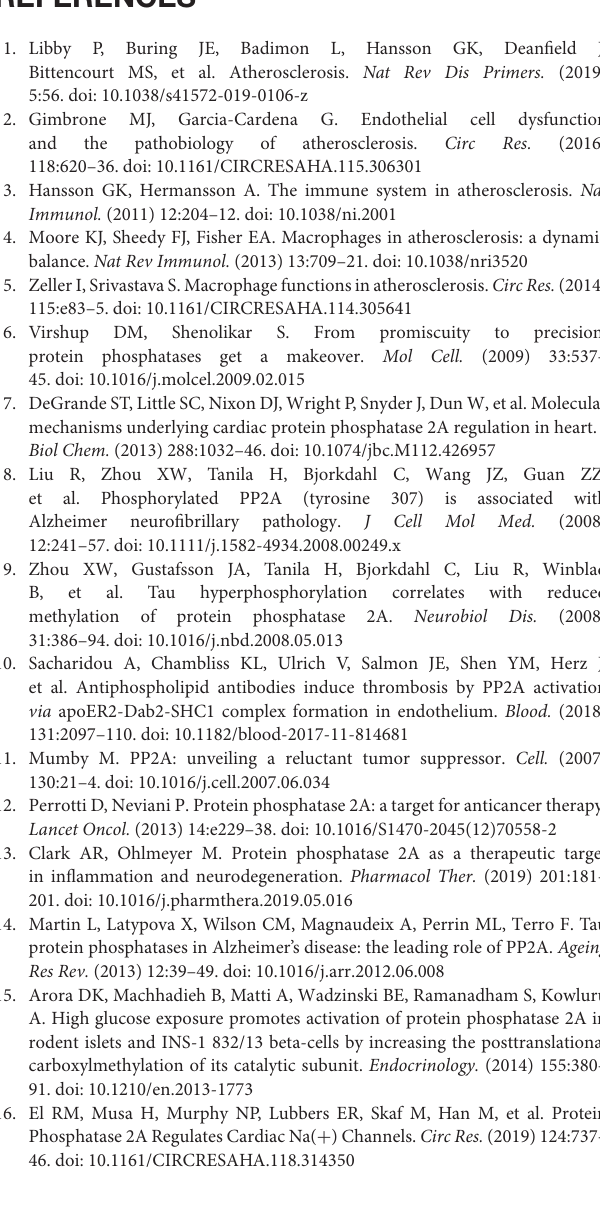
Supplementary Figure 2 | (A) Western blot assessment of LDLR in the liver of fl/fl and cKO mice injected with AAV-GFP or AAV-PCSK9 after 16 weeks of high-fat and high-cholesterol diet feeding. Right panel: quantification of western blot. (B) Images of Oil-Red-O staining of whole aortas from fl/fl and cKO mice